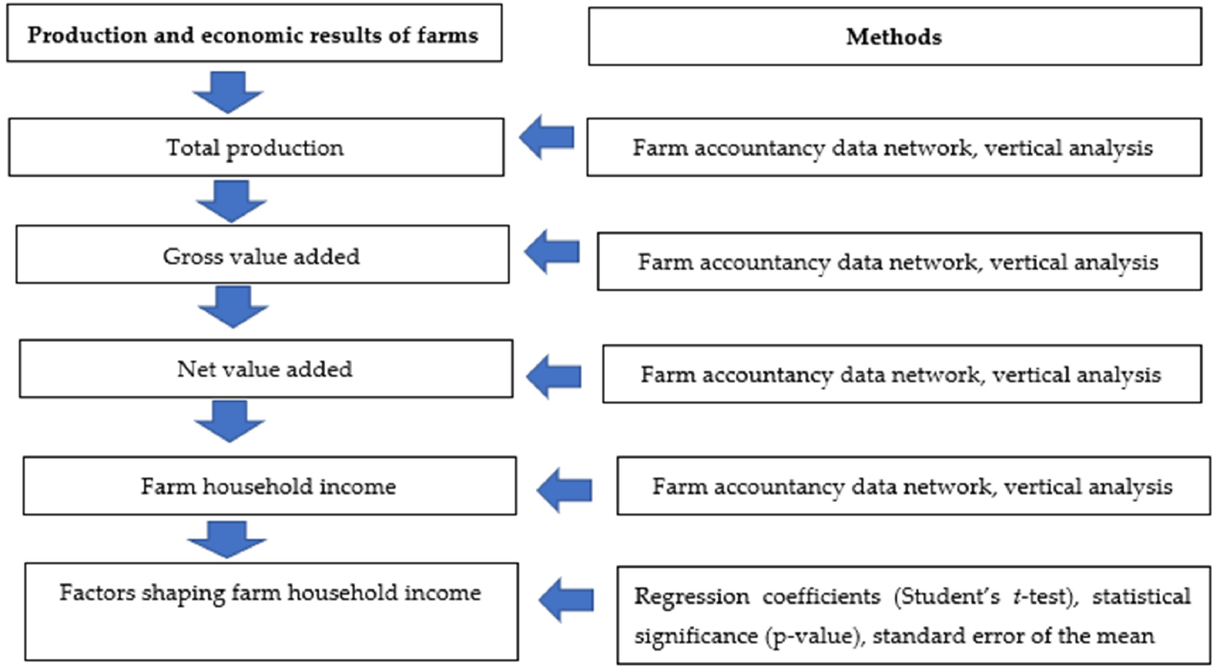
Figure 1. Production and economic results and the methods used to calculate them. Source: own elaboration based on FADN data [52].